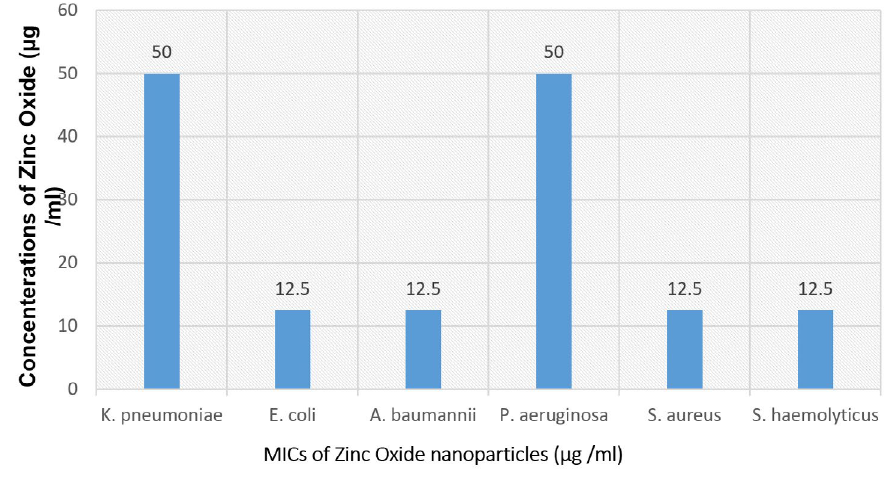
Fig. 13. Minimum inhibitory concentrations (MICs) histogram against the pathogenic bacterial